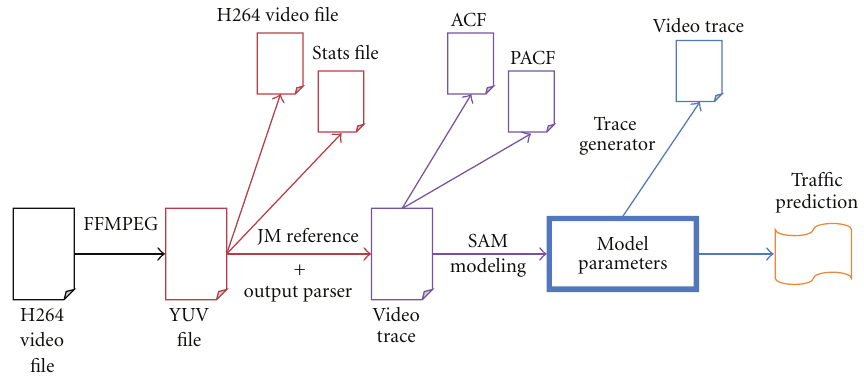
Figure 1: Modeling, analyzing, and generating video traces processes.